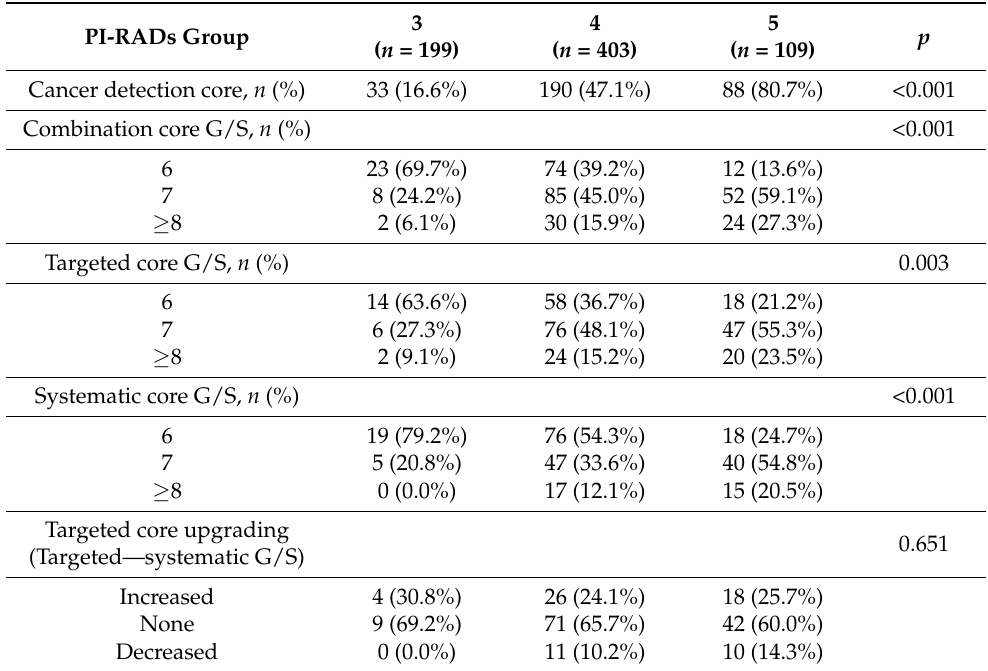
Table 2. Biopsy results.